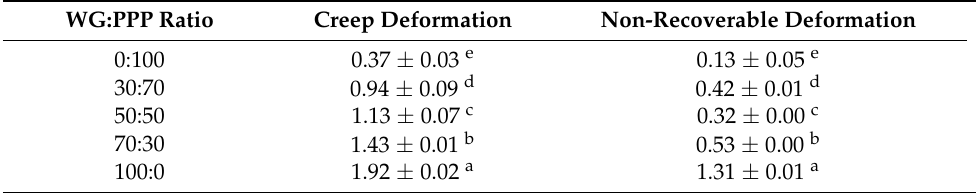
Table 3. Creep deformation and non-recoverable deformation of di ff erent raw materials.